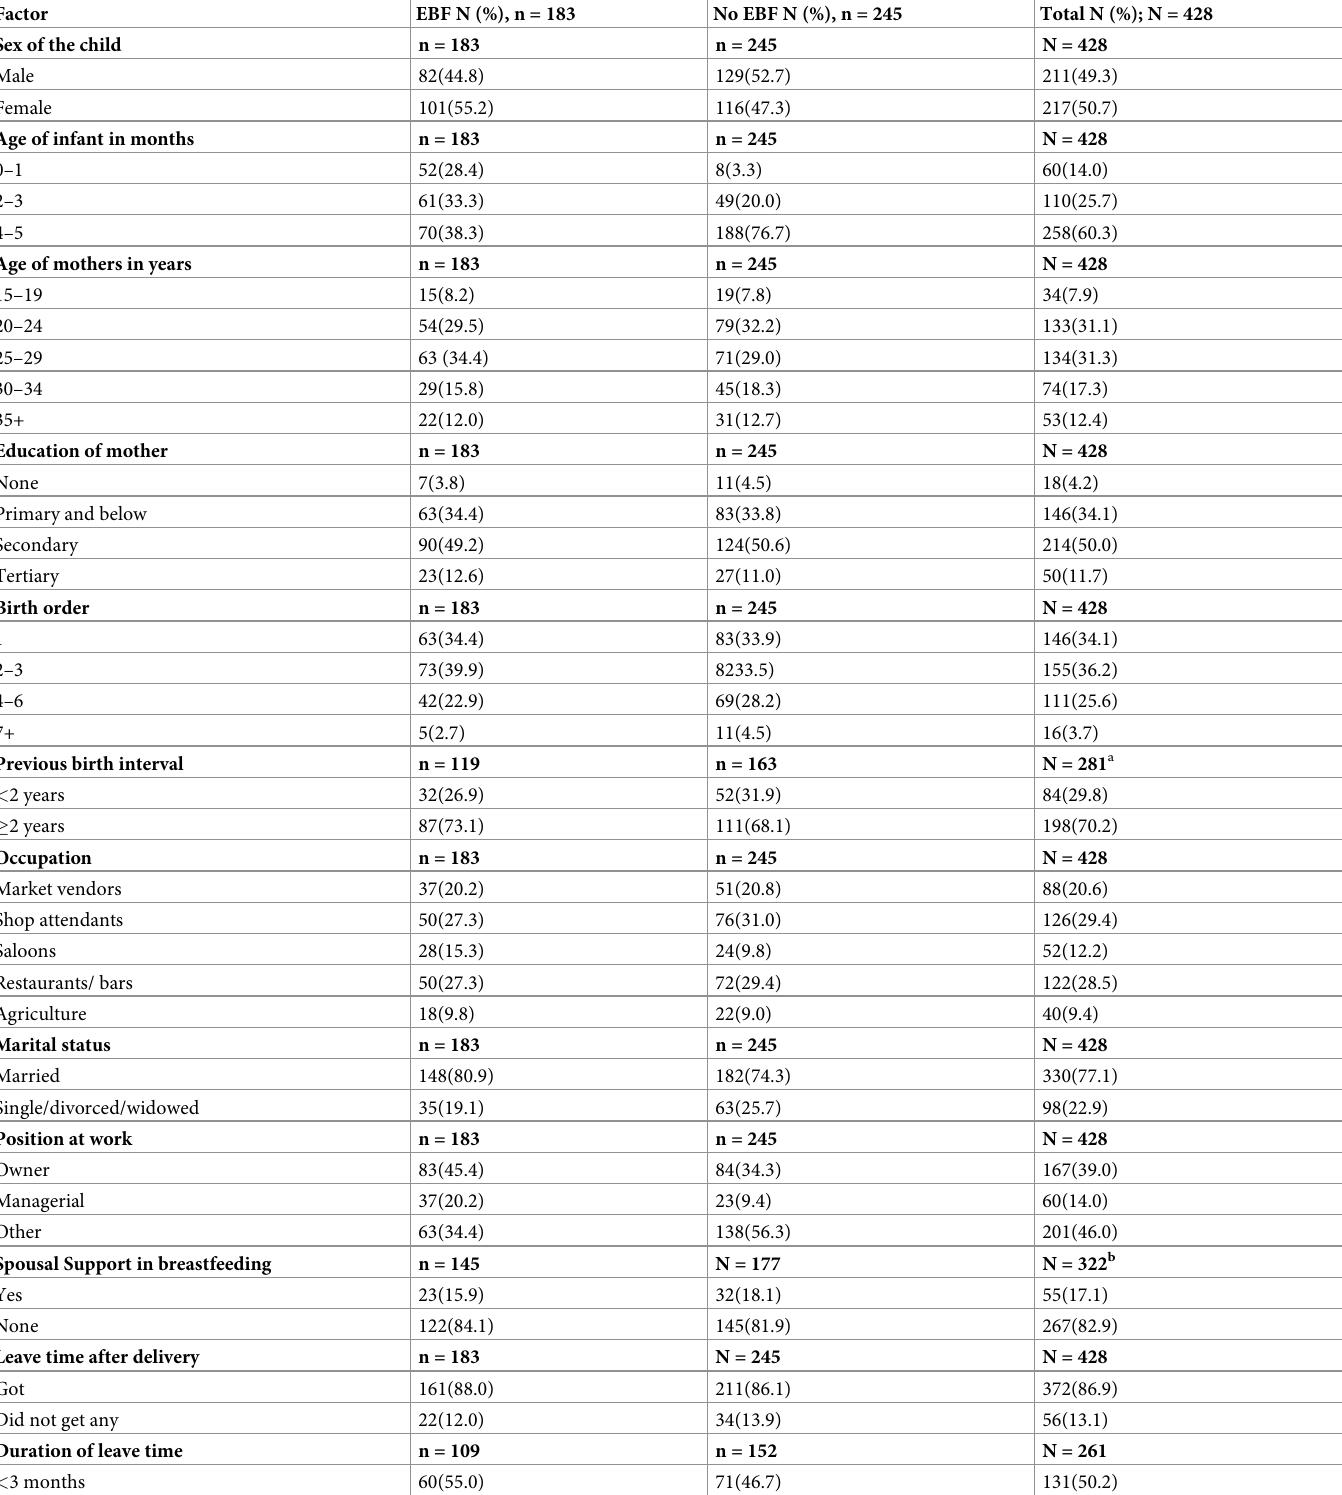
Table 2. Socio-demographic and household characteristics of study participants (N =